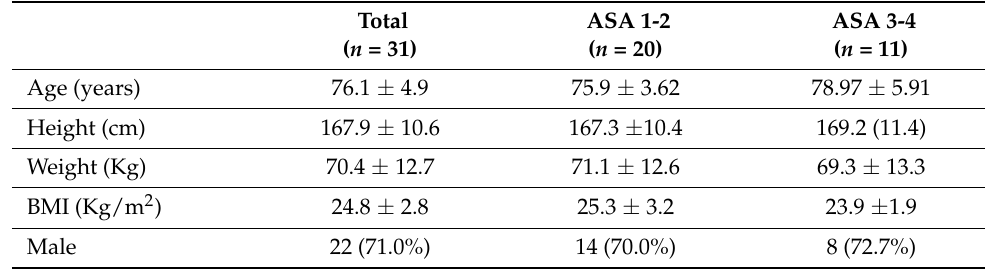
Table 1. Preoperative data, according to ASA class. BMI = Body Mass Weight, CFS = Clinical Frailty Scale, MET = Metabolic equivalent of tasks, DASI = Duke Activity Status